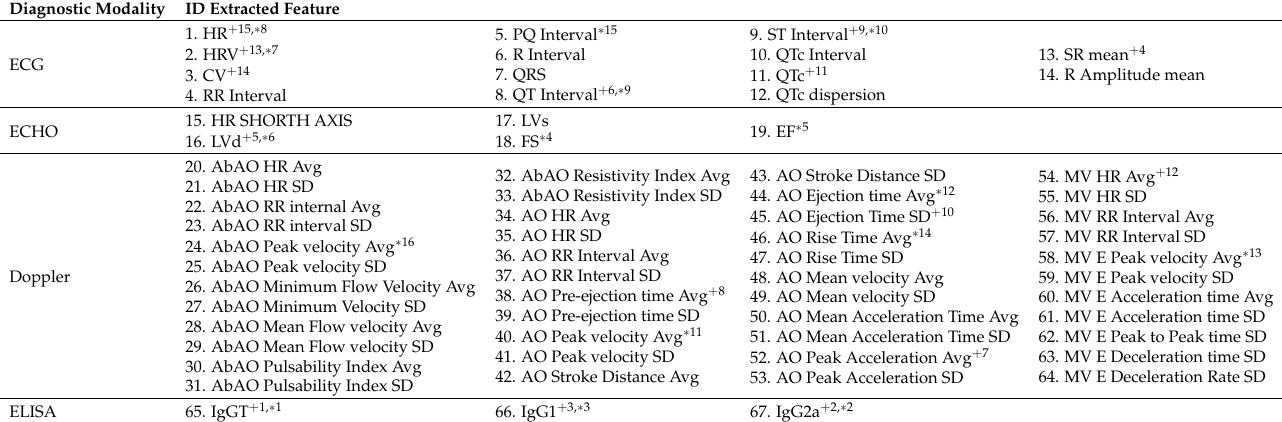
Table 1. Murine experimental multimodal features in Trypanosoma cruzi infection.